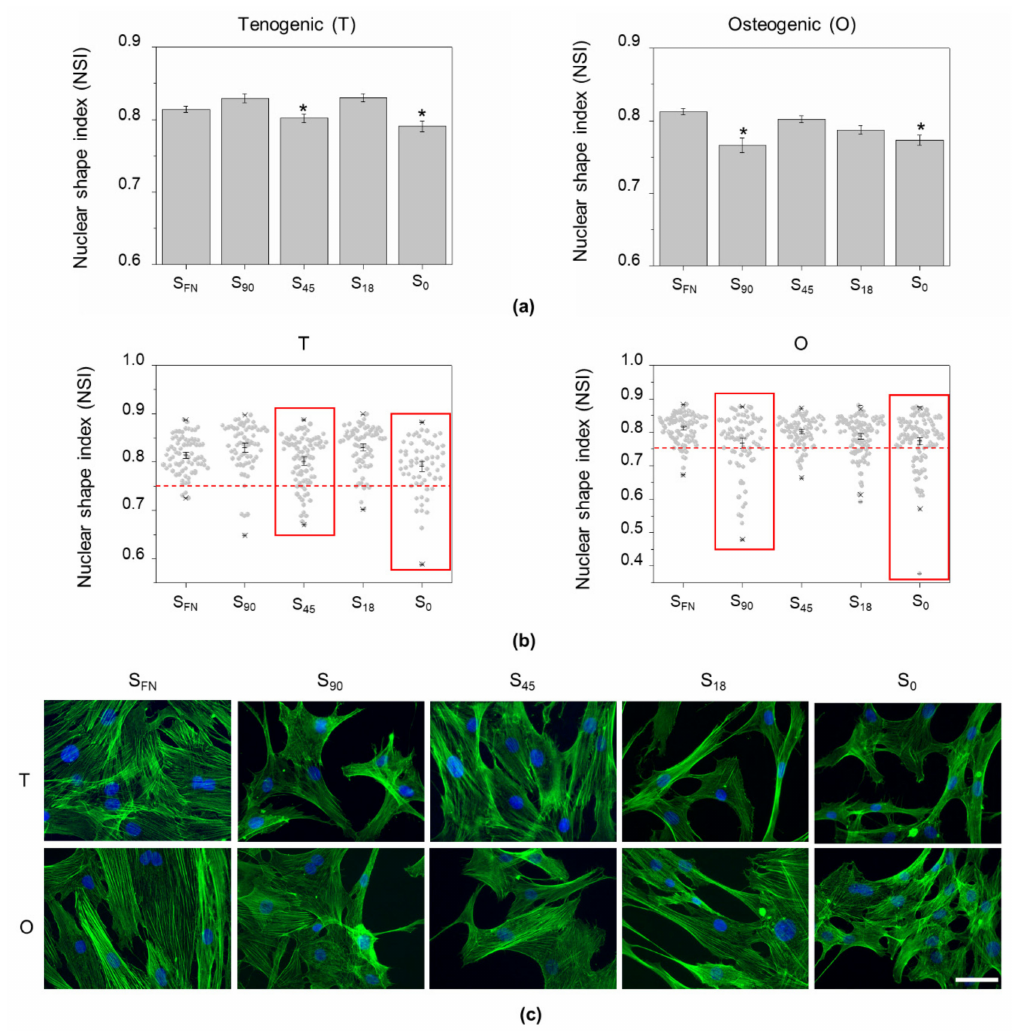
Figure 1. Nanopatterns induce nuclear shape remodeling depending on the di ff erentiation media used. ( a ) Nuclear shape index (NSI) calculated from Hoechst staining epifluorescence images on the di ff erent substrates taken after 24 h of tenogenic (T) or osteogenic (O) induction. Nuclei deformation was more pronounced on S 45 for tenogenesis and on S 90 for osteogenesis, with values similar to those of their respective negative controls (S 0 ). Data are given as the mean ± SE. ( b ) Column scatter plots from data presented in ( a ) showing the highest nuclear polarization values. Data accumulation below NSI = 0.75 (red dashed line) is observed, especially for substrates with the lowest NSI (delimited in red). ( c ) Representative epifluorescence images of human adipose-derived mesenchymal stem cells (hAMSCs) after 24 h of culture (under T or O induction), stained for phalloidin and Hoechst for F-actin fibers and nuclei visualization, respectively. Cells on S 45 (T) and S 90 (O) present an actin configuration that resembles that of their respective positive controls (S FN ) on fibronectin (FN) rather than that of the negative controls (S 0 ). Scale bar = 50 µ